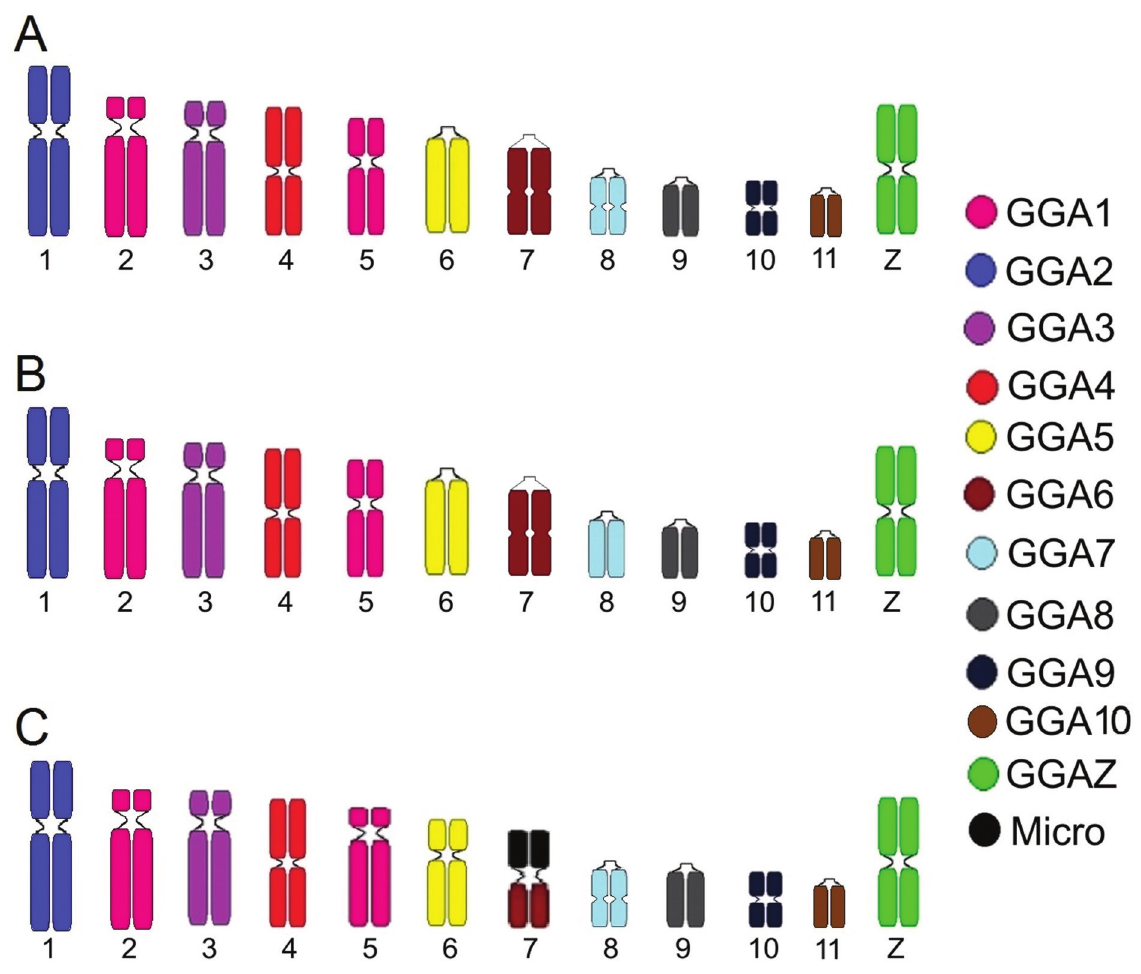
Figure 3 - Homology map between G. gallus and three swallow species: P. tapera (A) and P.chalybea (B), P. cyanoleuca